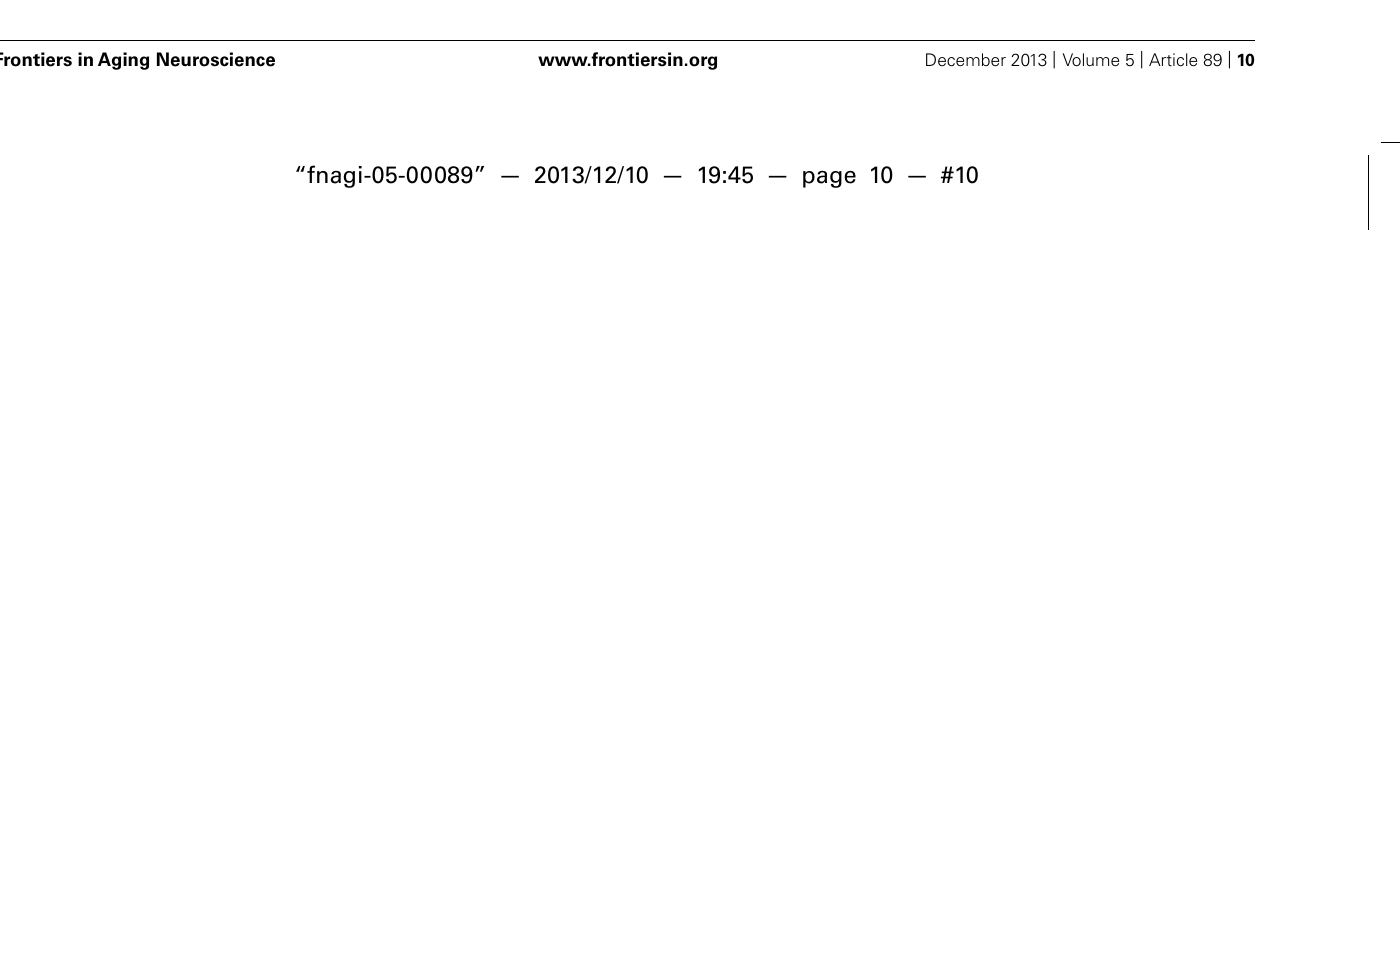
topographic maps are displayed on the right with electrode cluster used for analysis indicated. Each head map represents 100 ms average and color voltage scale is